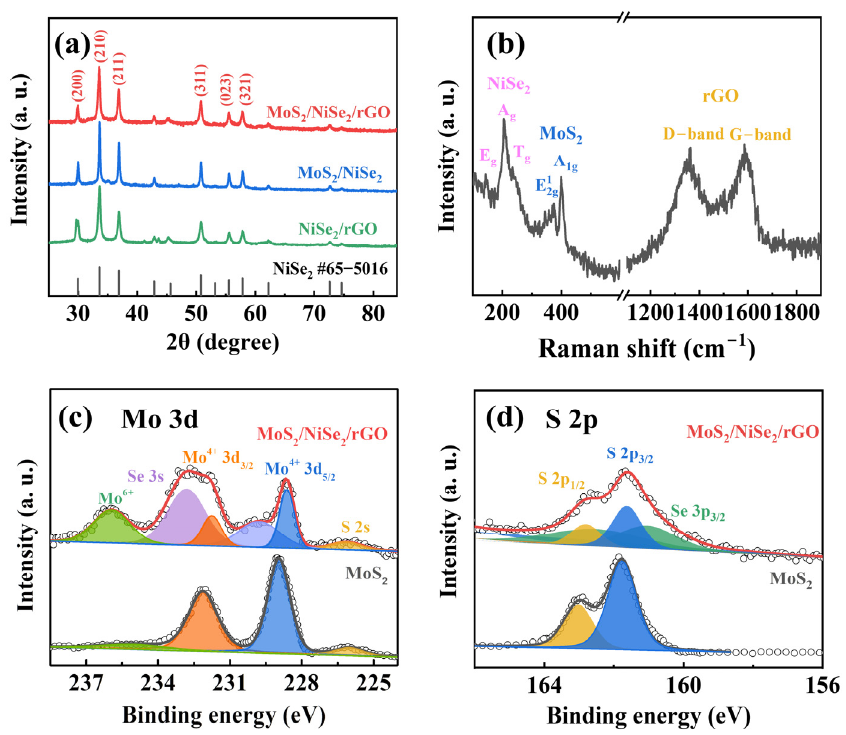
Figure 2. Chemical analysis of the MoS 2 /NiSe 2 /rGO. ( a ) XRD patterns of MoS 2 /NiSe 2 /rGO, MoS 2 /NiSe 2 , and NiSe 2 /rGO. ( b ) Raman spectra of MoS 2 /NiSe 2 /rGO. XPS spectra of ( c ) Mo 3d and ( d ) S 2p for MoS 2 and MoS 2 /NiSe 2 /rGO.